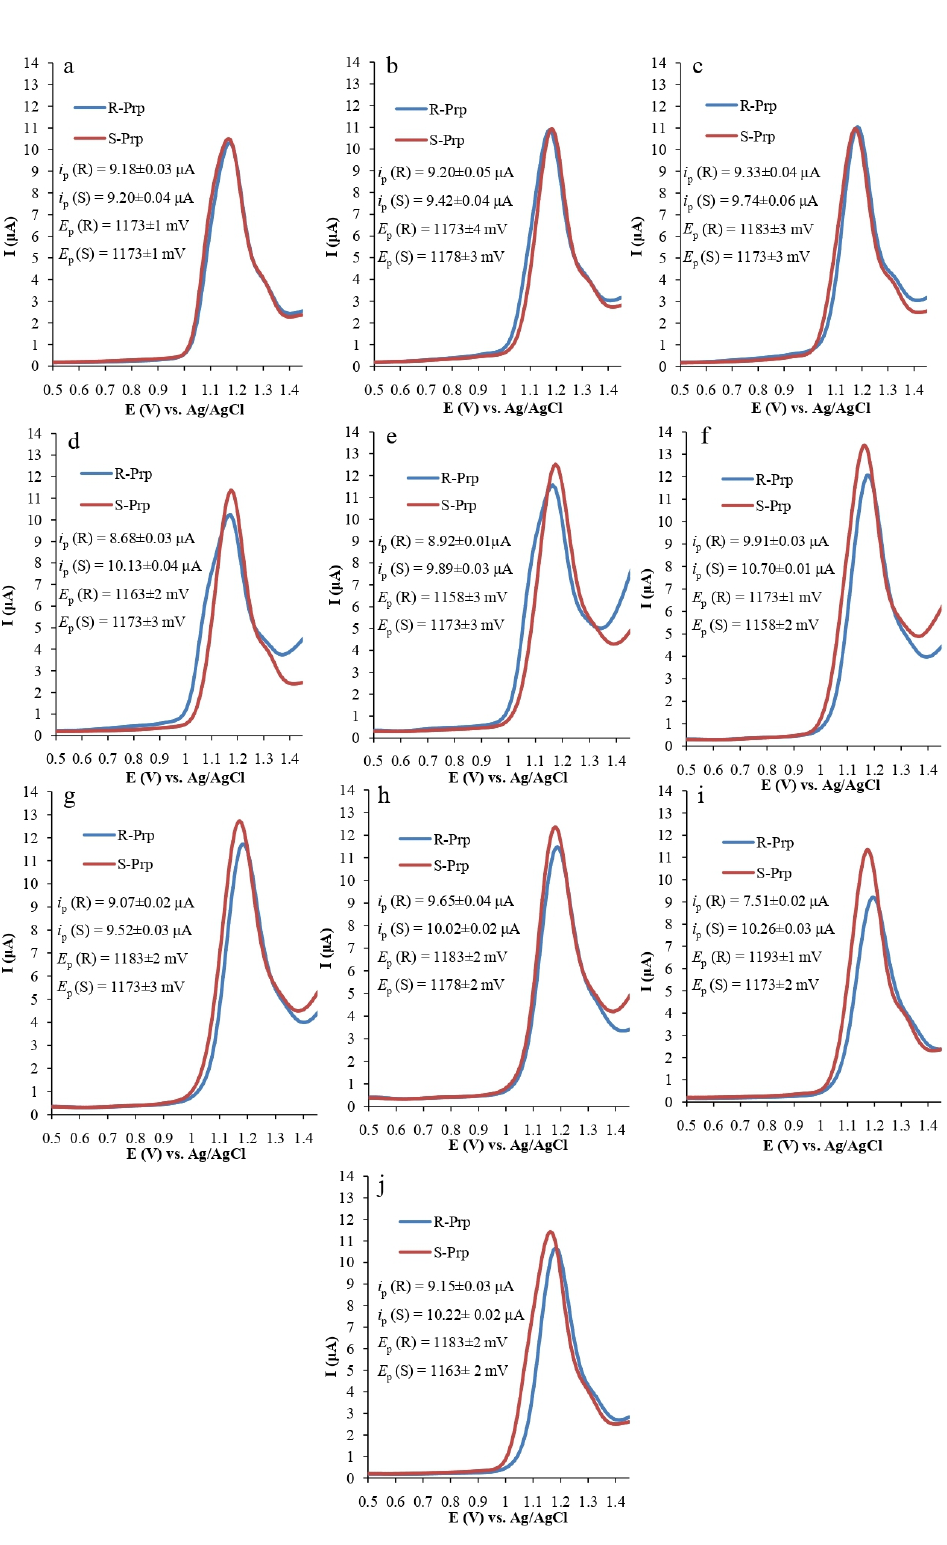
Figure 4. DPV of 1 mM solutions of R- and S-Prp on ( a ) GCE, ( b ) GCE/PEC, ( c ) GCE/PEC–( S - AlaH), ( d ) GCE/PEC–( S -PheH), ( e ) GCE/PEC–[Cu( S -PheH) 2 ], ( f ) GCE/PEC–[Zn( S -PheH) 2 (H 2 O)], ( g ) GCE/PEC–[Cu( S -AlaH) 2 ], ( h ) GCE/PEC–[Zn( S -AlaH) 2 (H 2 O)], ( i ) GCE/PEC–[Cu( S -Ala) 2 ]–[Cu( S - Phe) 2 ], and ( j ) GCE/PEC–[Zn( S -Ala) 2 (H 2 O)]–[Zn( S -Phe) 2 (H 2 O)] (0.05 M sulfuric acid, potential scanning rate 0.2